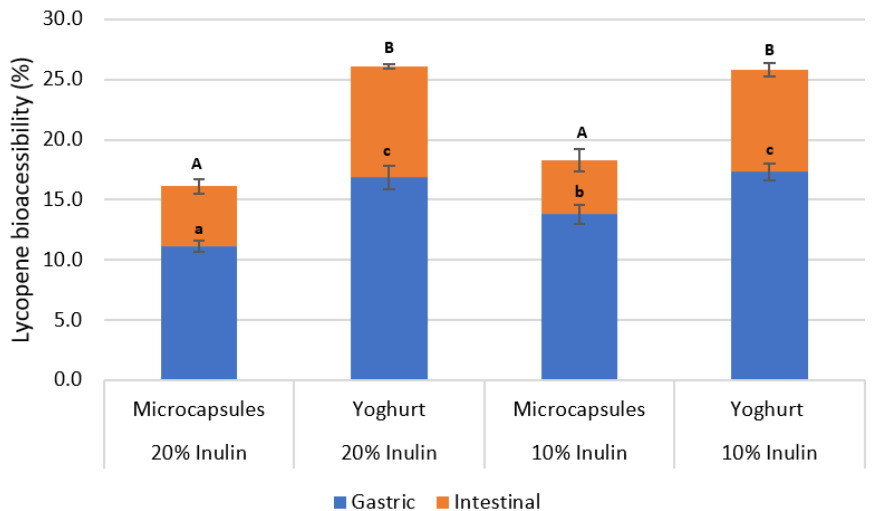
Figure 5. Lycopene release from the microcapsules alone and when incorporated into yoghurt, during a sequential static in vitro digestion: in simulated gastric fluid followed by simulated intestinal fluid. Different letters represent statistically significant differences among treatments (Tukey test p < 0.05): uppercase letters (during simulated intestinal fluid); lowercase letters (during simulated gastric fluid).